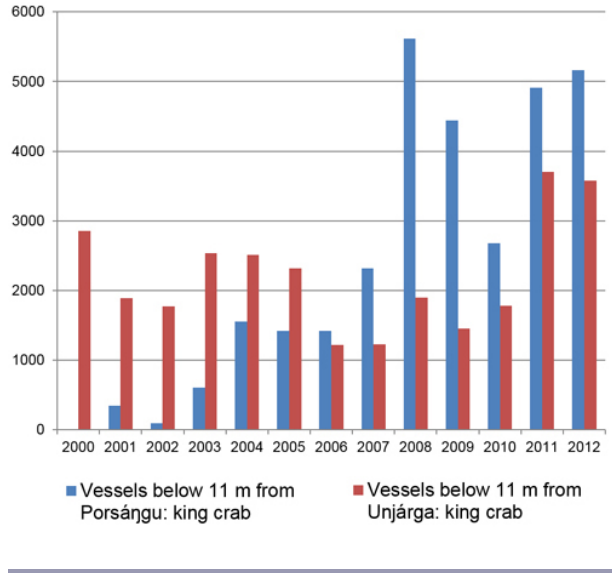
Fig. 3 . King crab ( Paralithodes camtschaticus ) catch (in 1000 Norwegian kroner) landed by vessels below 11 m from Porsá η gu and Unjárga, in the period 2000-2012. Municipalities of landings are all over Finnmark, but most of the catch is landed in the vessels’ home municipality or close by. Source: Directorate of Fisheries